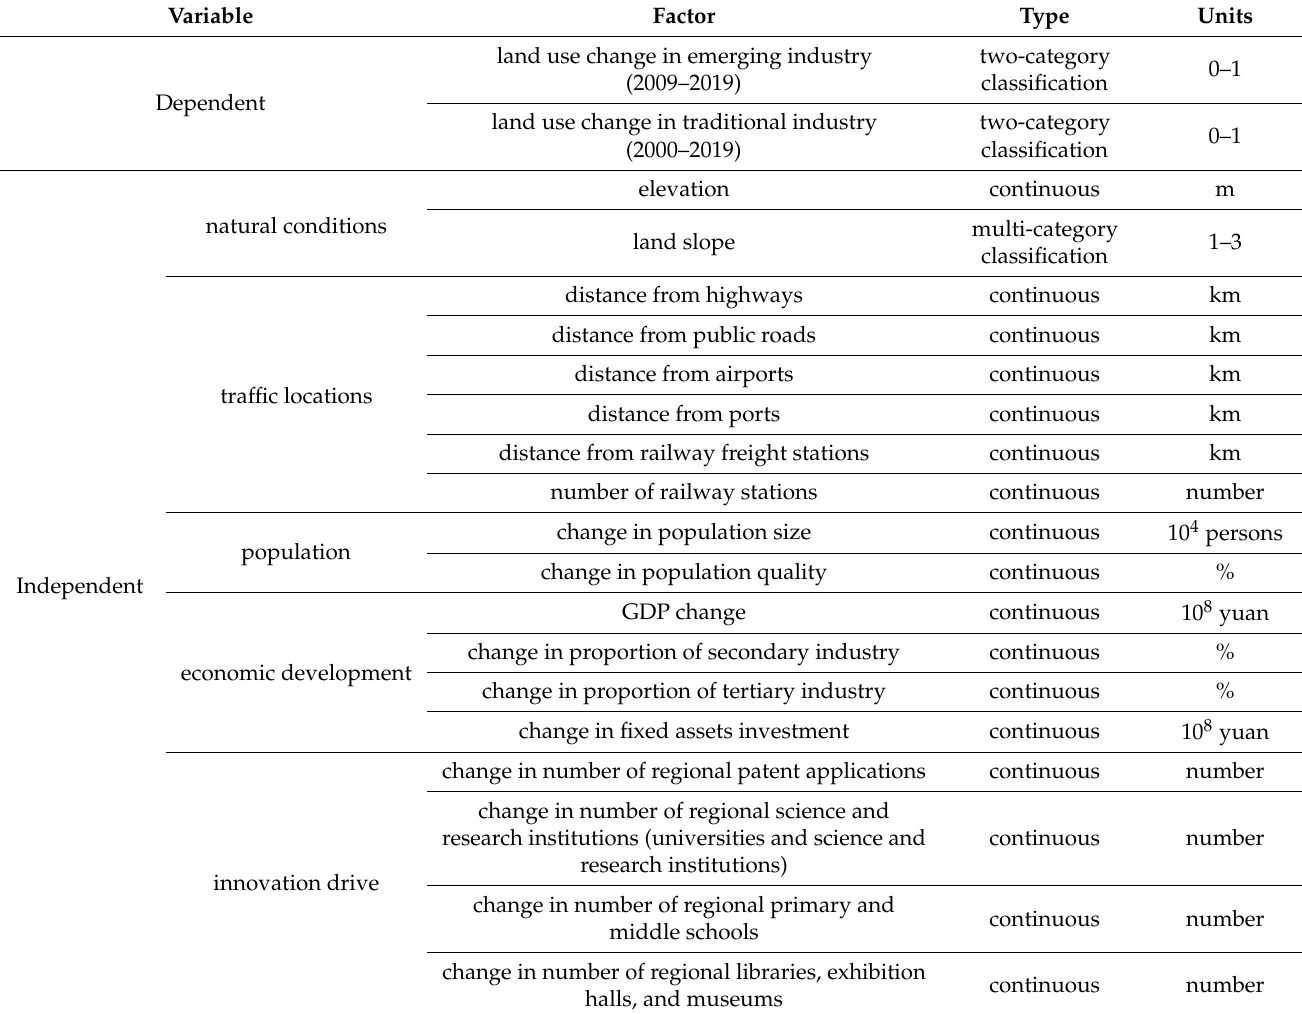
Table 2. Establishment of the dependent variables and independent variables dataset. Variable Factor